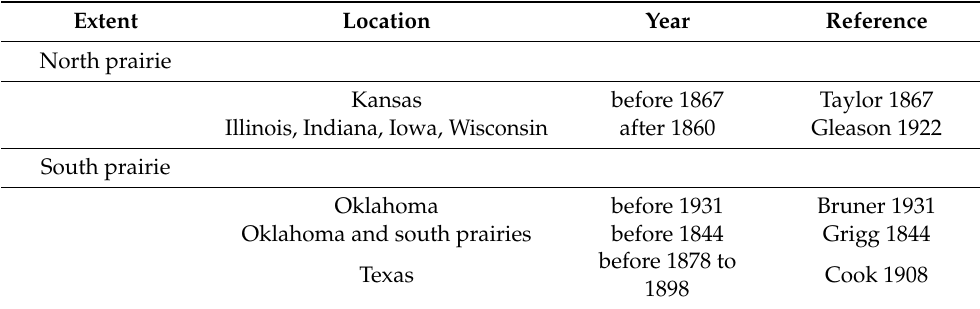
Table 2. Location and years when tree or shrub encroachment were documented in the two prairie